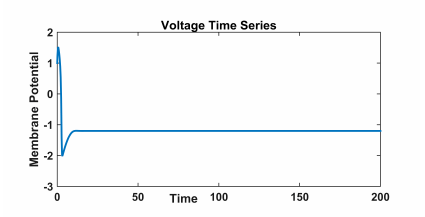
Figure 6. Recovery variable (right) without an external current I(t) = 0 µ A / cm 2 , a = 0.8 , b = 0.7 & c = 3